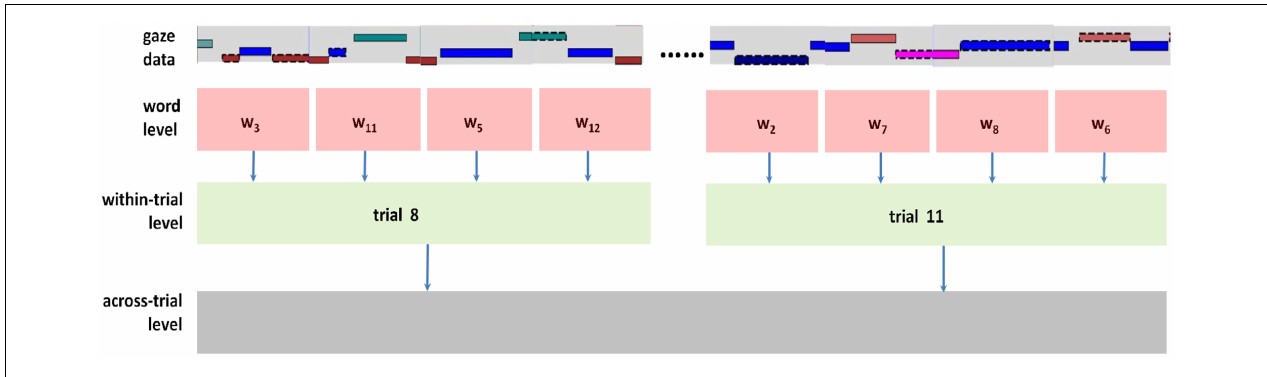
several words within a trial; (3) across-trial level: how they adjusted their attention on objects in a new trial based on where they looked in previous